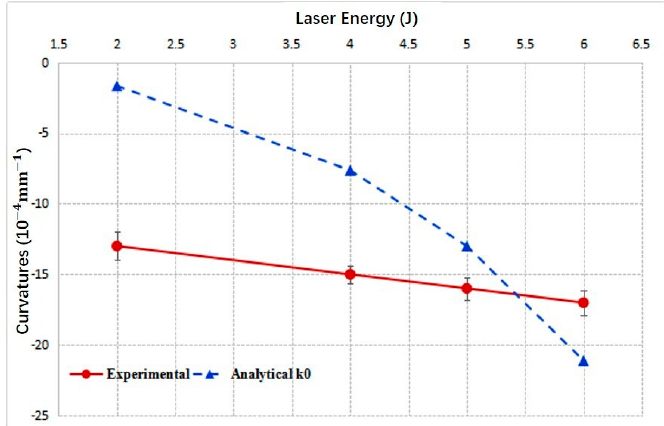
Figure 7. Curvatures of 3 mm 2024 aluminum alloy vs. laser pulse energies.